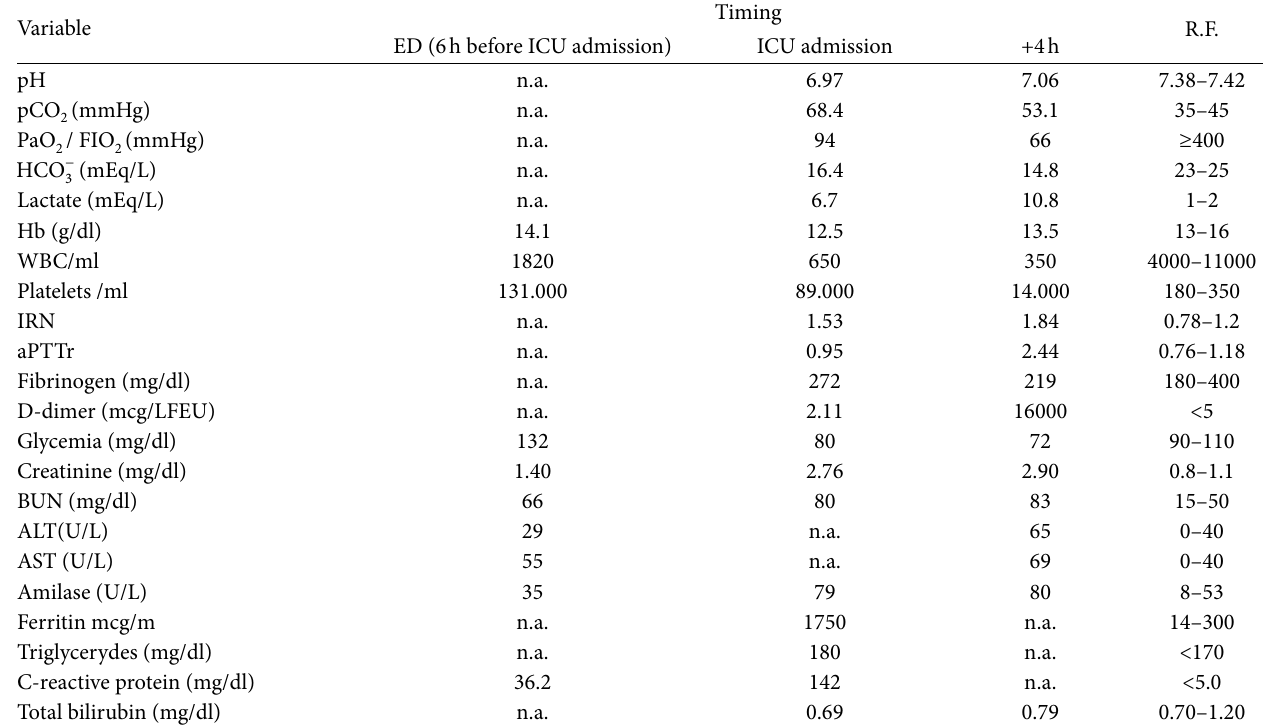
Table 1: Time course of some blood biological